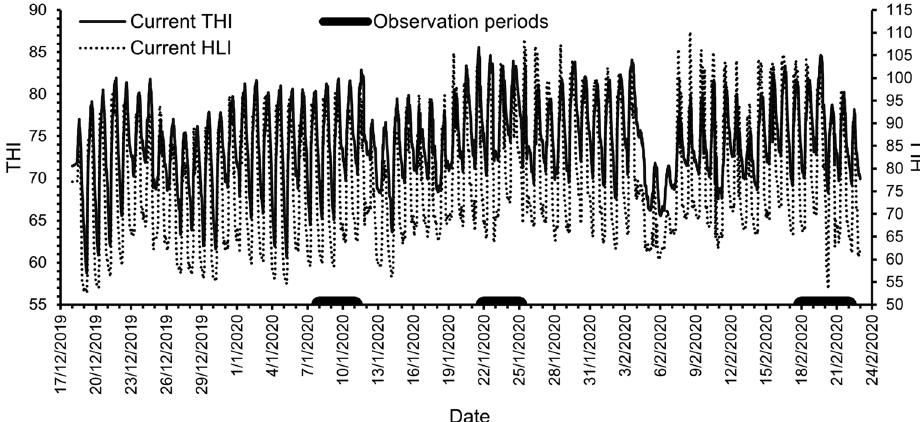
Figure 7. Temperature humidity index (THI, solid line) and heat load index (HLI, dotted line) calculated at 10-min intervals across the experimental days. The solid bars on the x -axis indicate the three observation periods. Data were recorded every 10-min across